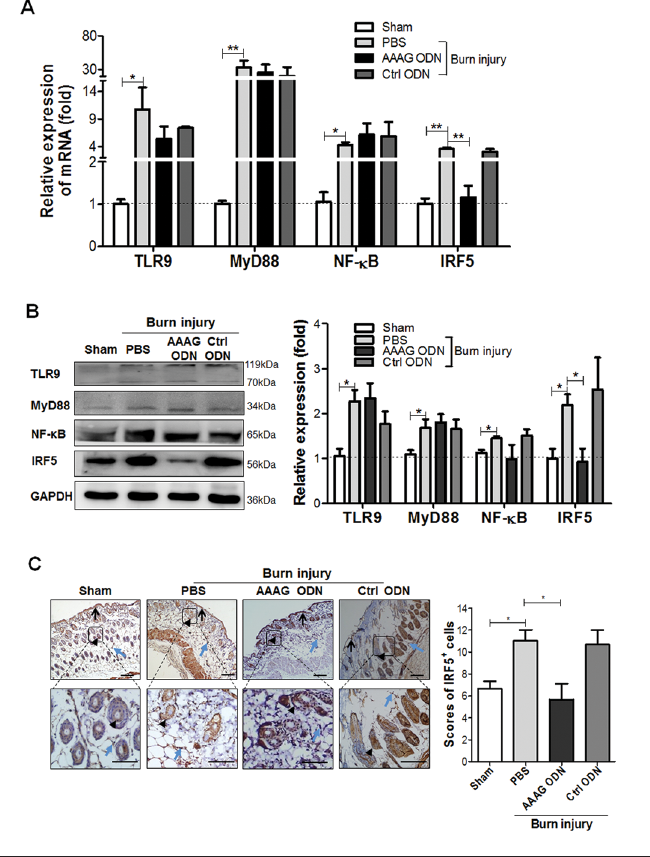
Figure 3. Effect of AAAG ODN on the TLR9-IRF5 pathway in burn-injured skin of the mice. The skin tissues collected from sham and burn-injured mice (3/group) at 0.5 h post burn injury were detected for (A) mRNA and (B) protein levels of TLR9, MyD88, NF- κ B and IRF5 by qPCR and Western blot, and for (C) IRF5 expression by immunohistochemistry (IHC). Arrows, black arrowheads and blue arrowheads denote keratinocytes in the epidermis, keratinocytes in hair follicles and fibroblasts in dermis, respectively. Brown represents expression of IRF5 protein. The bars in column charts represent SEM for means; *P < 0.05, **P < 0.01, ***P < 0.001. In the IHC images, scale bars correspond to 100 μ m and magnification is x 200 (upper panel) and x 400 (lower